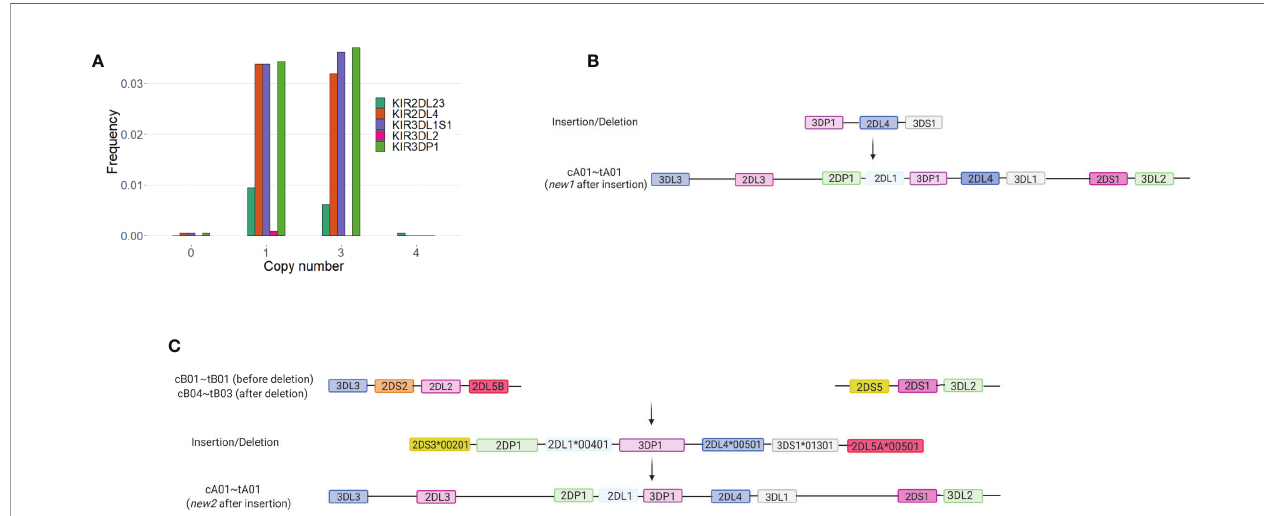
FIGURE 2 | Deletions and duplications involving KIR2DL4 , KIR3DL1S1 , and KIR3DP1 were observed in more than 6% of KIR haplotypes Together with KIR2DL23 and KIR3DL1S1 , framework genes ( KIR3DL3 , KIR3DP1 , KIR2DL4 , and KIR3DL2 ) were initially considered to be present in all KIR haplotypes, with only rare exceptions. Here, we show that deletions and duplications in these genes are relatively frequent in the study population. (A) Frequencies of gene copy number for individual genes. (B) Suggested origin of the novel haplotype containing a duplication of KIR3DP1~KIR2DL4~KIR3DS1 and observed in 38 individuals ( f = 0.009). Created with BioRender.com. (C) Suggested origin of the novel haplotype containing a duplication of KIR2DS3~KIR2DP1~KIR2DL1~KIR3DP1~KIR2DL4~KIR3DS1~ KIR2DL5A , observed in 19 individuals ( f = 0.004). Figure created with